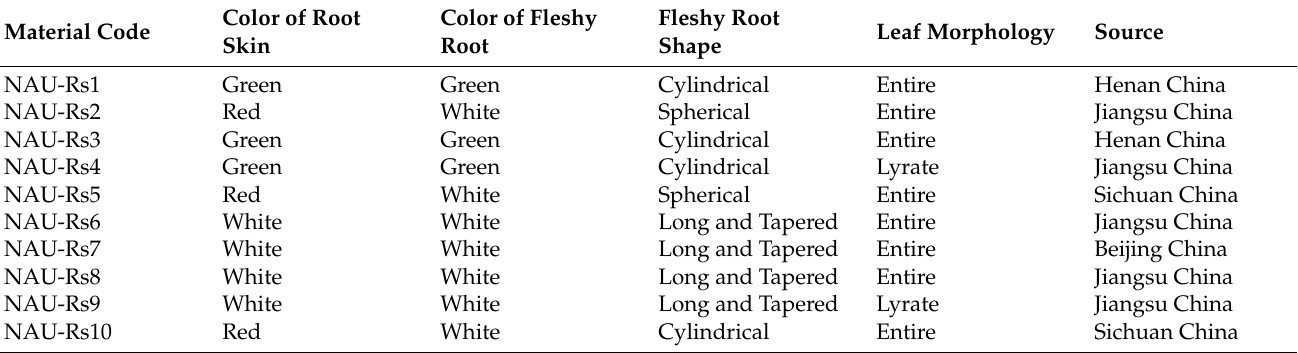
Table 7. Materials of radish used in this